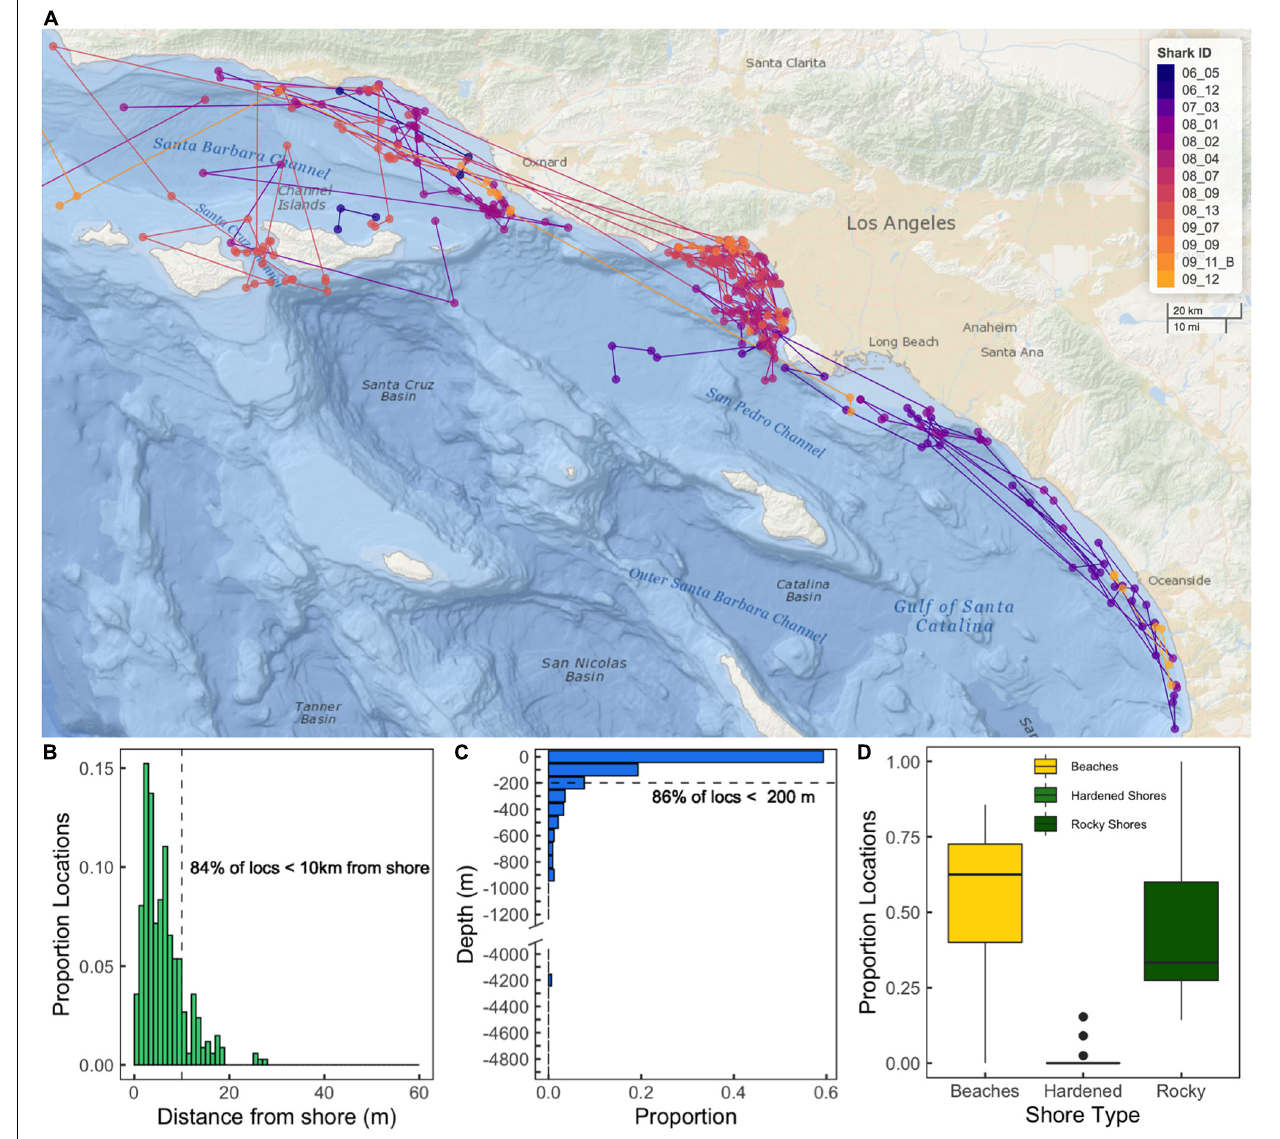
FIGURE 2 | (A) Map of SPOT tag (ARGOS) locations colored by the individual shark ID. Lines represent the shortest path between subsequent locations for an individual shark. (B) Histogram showing proportion of ARGOS locations with respect to distance from shore. (C) Histogram of proportion of ARGOS locations with respect to underlying water column depth. N.b. the break in the y -axis after 1200 m, as there were no locations with associated depth between 1500 and 4000 m. (D) Box plot showing proportion of ARGOS locations with respect to shore habitat type. Box extents show interquartile range of proportions. Solid lines show median